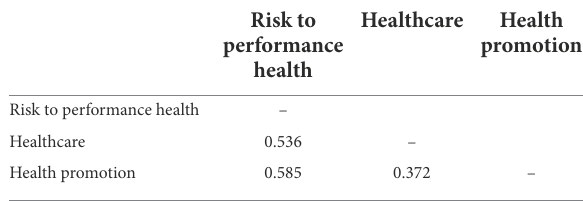
TABLE 4 Correlations among